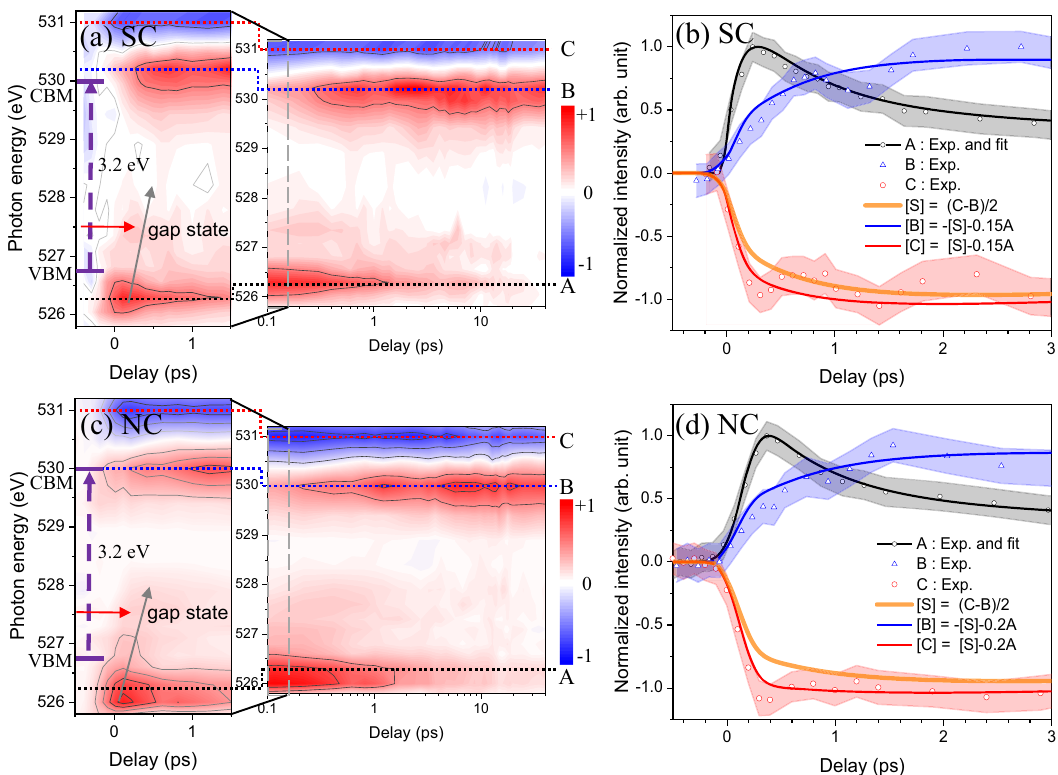
Fig. 4 Initial behavior of photo-generated holes near the band gap region probed by oxygen K-edge. Experimental data of the transient signal as a function of pump-probe delay in the energy regions between VB and CB (525.8~531.2 eV) for anatase TiO 2 ( a ) SC and ( c ) NC. Red: increased absorption intensity; blue: decreased absorption intensity; purple arrows: abrupt changes in transient signals by electron excitation; green arrows: traces of hole peak times from A to gap state. Red arrows: positions of center of gap states. The VBM and CBM were determined from XAS spectrum at oxygen K-edge by the linear extrapolation method. (Supplementary Fig. S2) b , d Normalized transient signals at three different photon energies (A (526.3 eV), B (530.2 eV for SC and 530.0 eV for NC), and C (531.0 eV).) during initial time delays for ( b ) SC and ( d ) NC. Experimental data (dot) agree well with calculation of our model (line). Shaded regions correspond to the standard